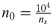
Phase diagram α v D for ns = 1, 2, …, 6 sources, L = 10, N = 104
L and k = 2.The point D = 0 is excluded from the diagram since it refers to isolated populations with threshold αc = λ/4 = 0.25. In all the cases n0=104ns, where n0 is the initial subpopulation size. The lines are obtained from Eqs (3) and (4). At the bottom of each plot we show the optimal dispersal D* and the corresponding maximum allowed mortality rate αmax(D*) below which the population still stay in the survival phase.